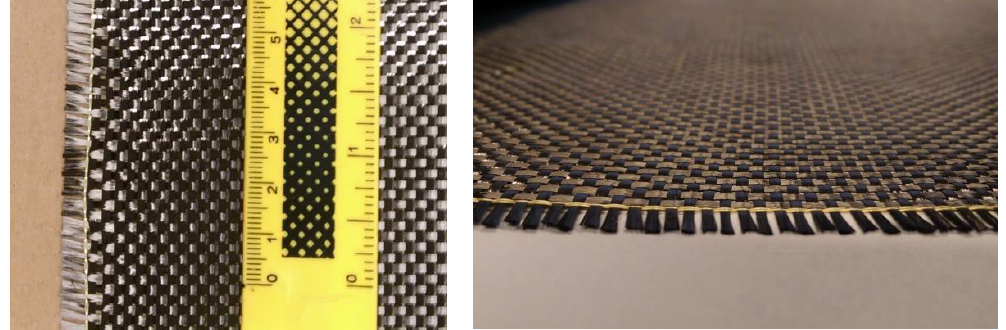
Figure 3. Schematics of plan and elevation views of bi-directional carbon fiber fabrics.